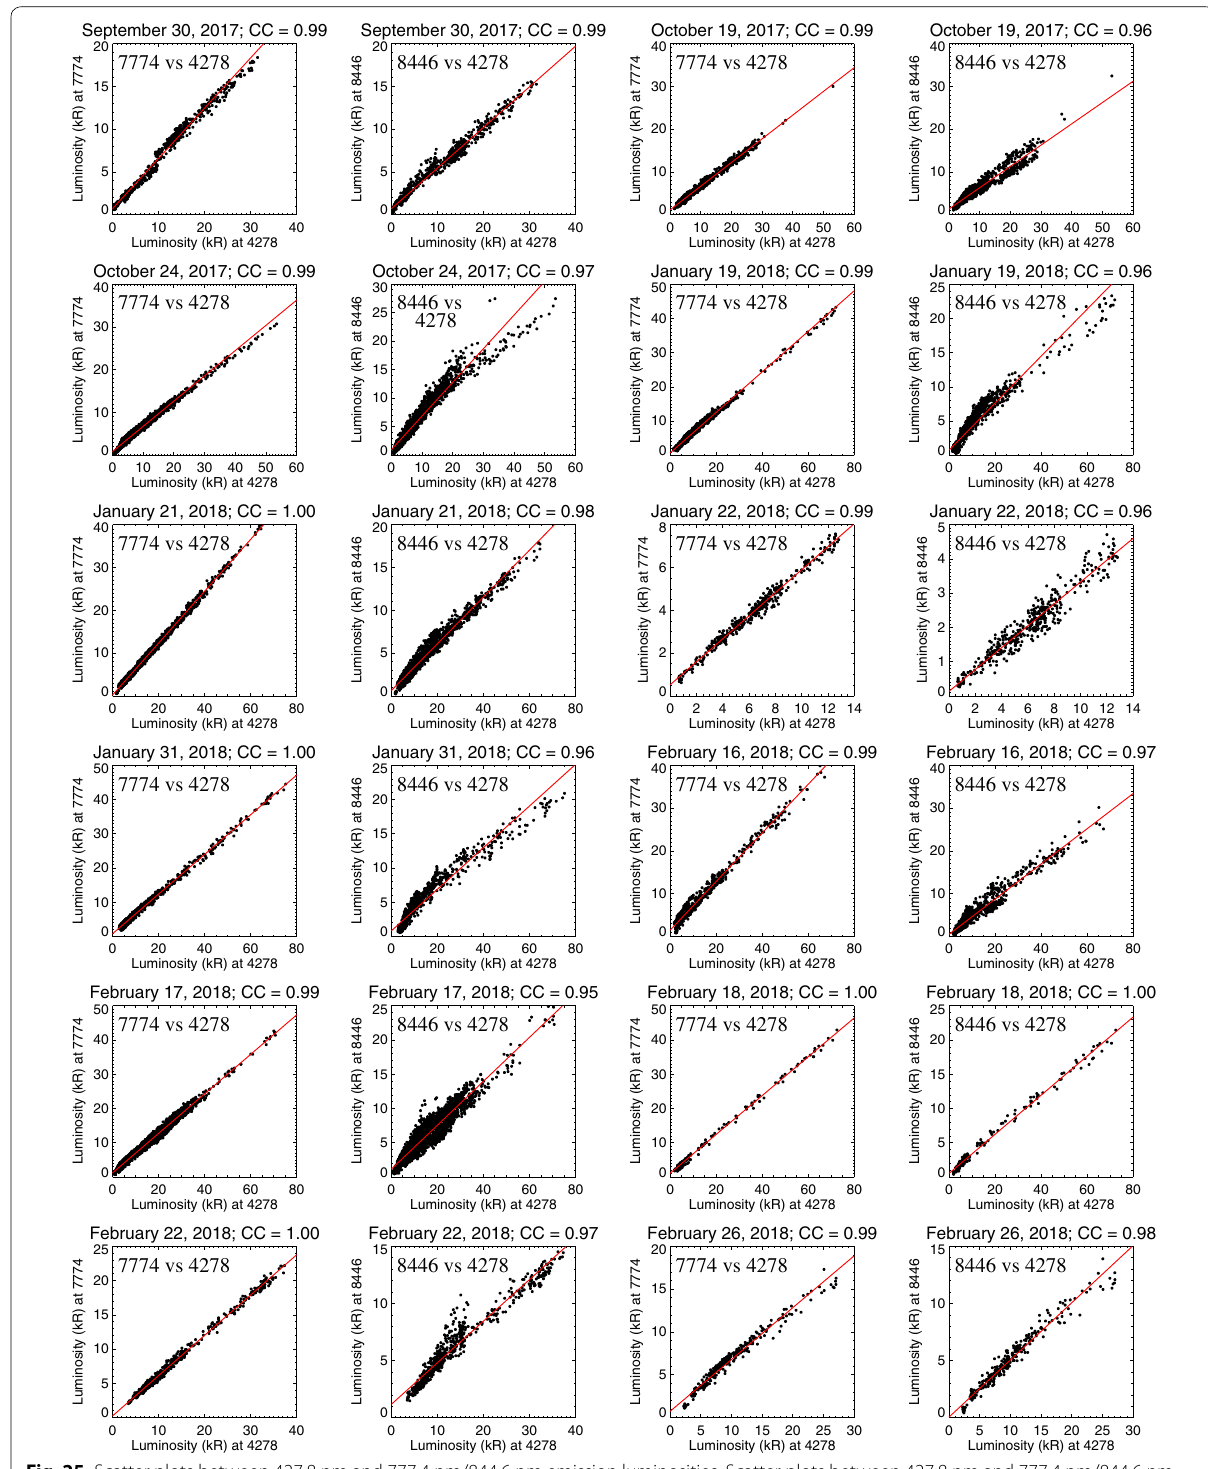
Fig. 25 Scatter plots between 427.8 nm and 777.4 nm/844.6 nm emission luminosities; Scatter plots between 427.8 nm and 777.4 nm/844.6 nm emission luminosities for 12 nights. Red solid lines are fitted lines determined with the least square